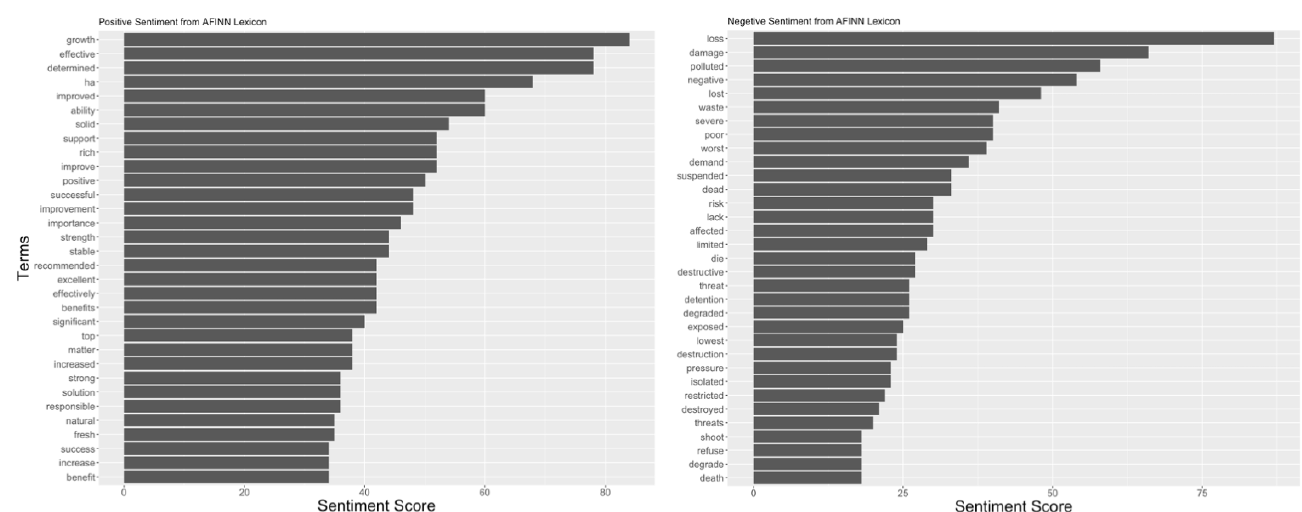
Figure 5. Top 30 highest positive and negative scoring sentiment words in the dataset.